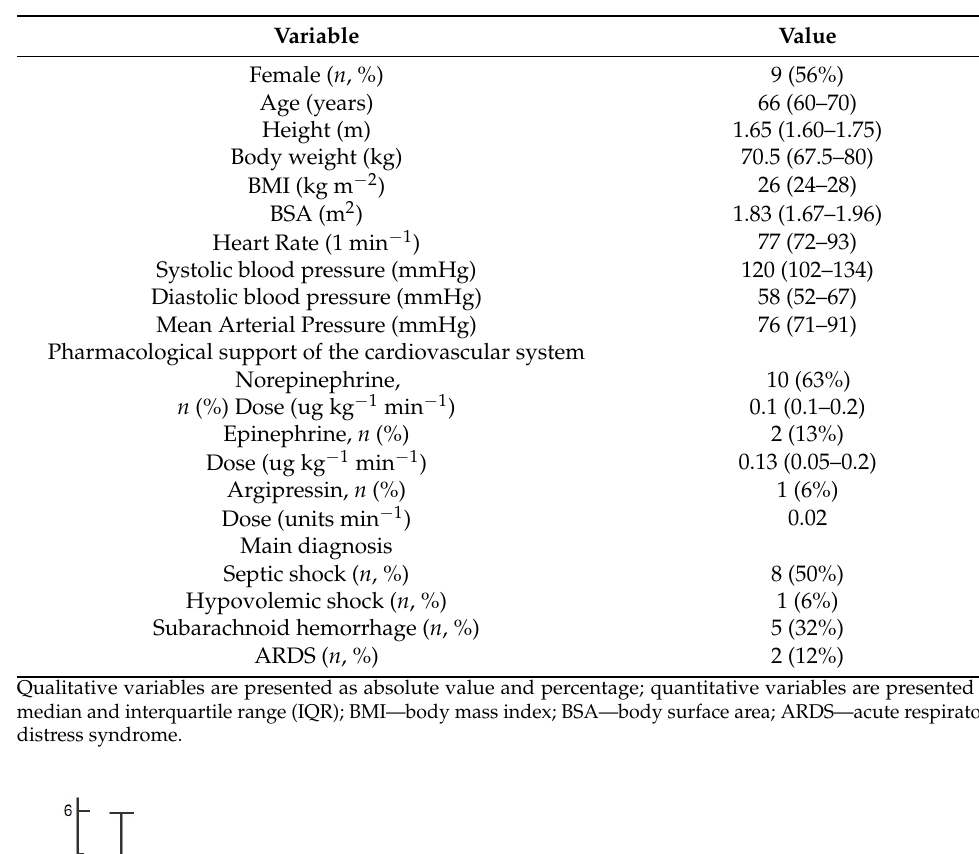
Table 1. The characteristics of the demographic and clinical data selected.